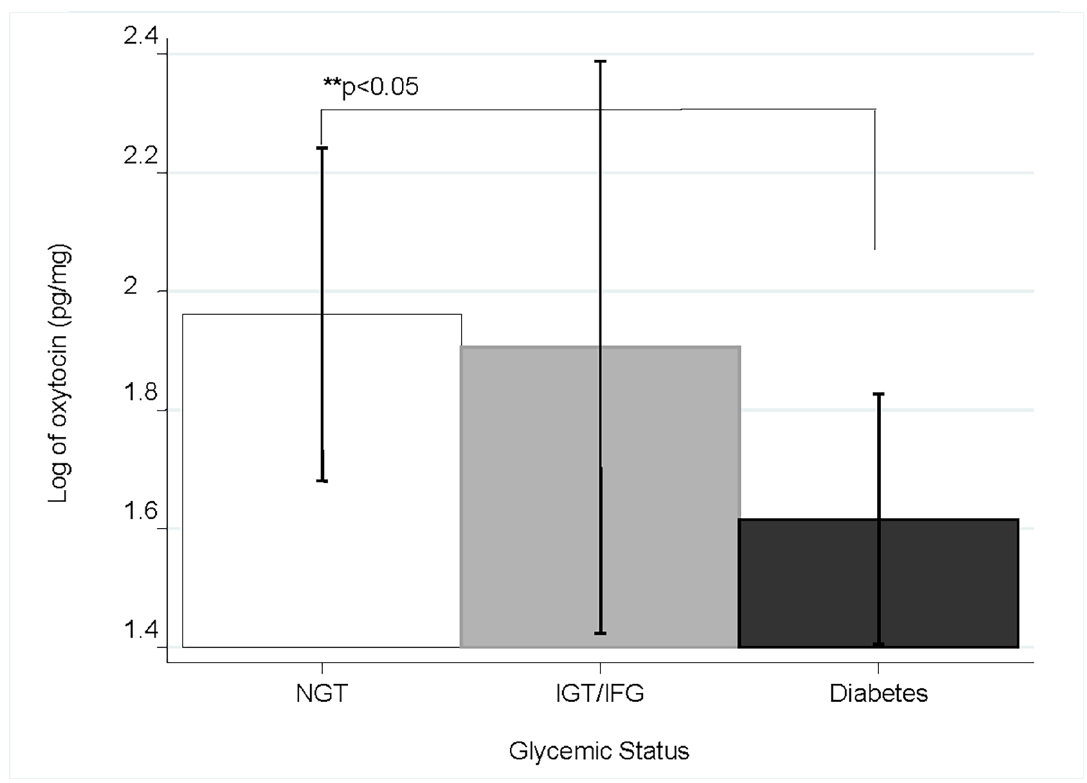
Fig 1. Oxytocin values by glycemic status. NGT = Normal glucosetolerance, IGT = Impairedglucosetolerance, IFG = Impaired fasting glucose.